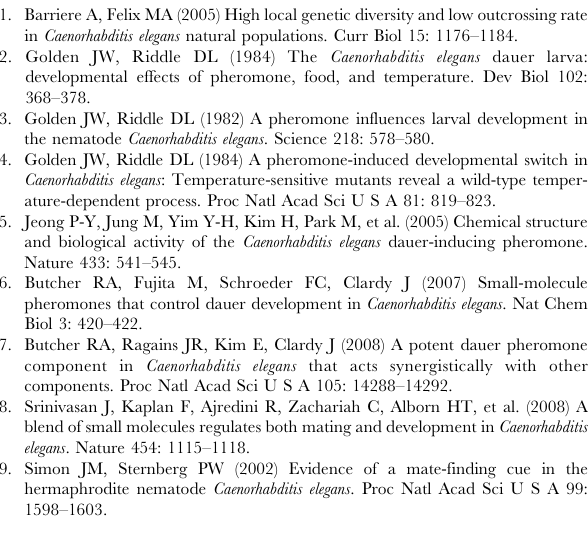
Figure S1 LC-MS profile of ascarosides of YA used for the male attraction assay. (A) ascr # 2, ascr # 3 and ascr # 4 and their m/z ratios. (B) MSMS analysis of asc # 8 M + 1 ion at m/z 264 using isolation with of 2 m/z, normalized collision energy of 35%, activation Q 0.200 and activation time 30 ms giving a dominating and characteristic M + 1-18 fragment at m/z 246. Upper panel is for the RIC for ascr # 8 standard (0.3 ng/ m l), young adult WW, young adult WW spiked with ascr # 8 (0.3 ng/ m l) and lower panel is solvent control profile showing no corresponding m/z 246 fragment.